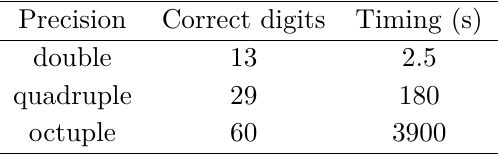
Table 5. Evaluation times of all pentagon functions on a typical phase-space point. Evaluation is performed in a single